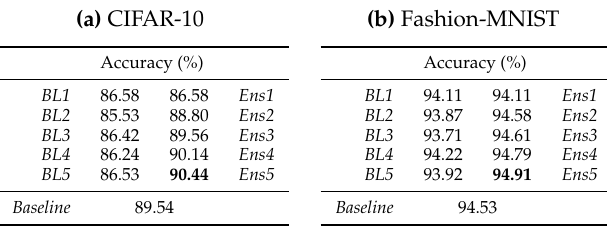
Table 13. Bagging results applied on the best models on: (a) CIFAR-10 dataset (NAG model that incorporates Data Augmentation and Batch Normalization); and (b) Fashion-MNIST dataset (Adam model that uses Data Augmentation, Batch Normalization and Dropout regularization methods.).